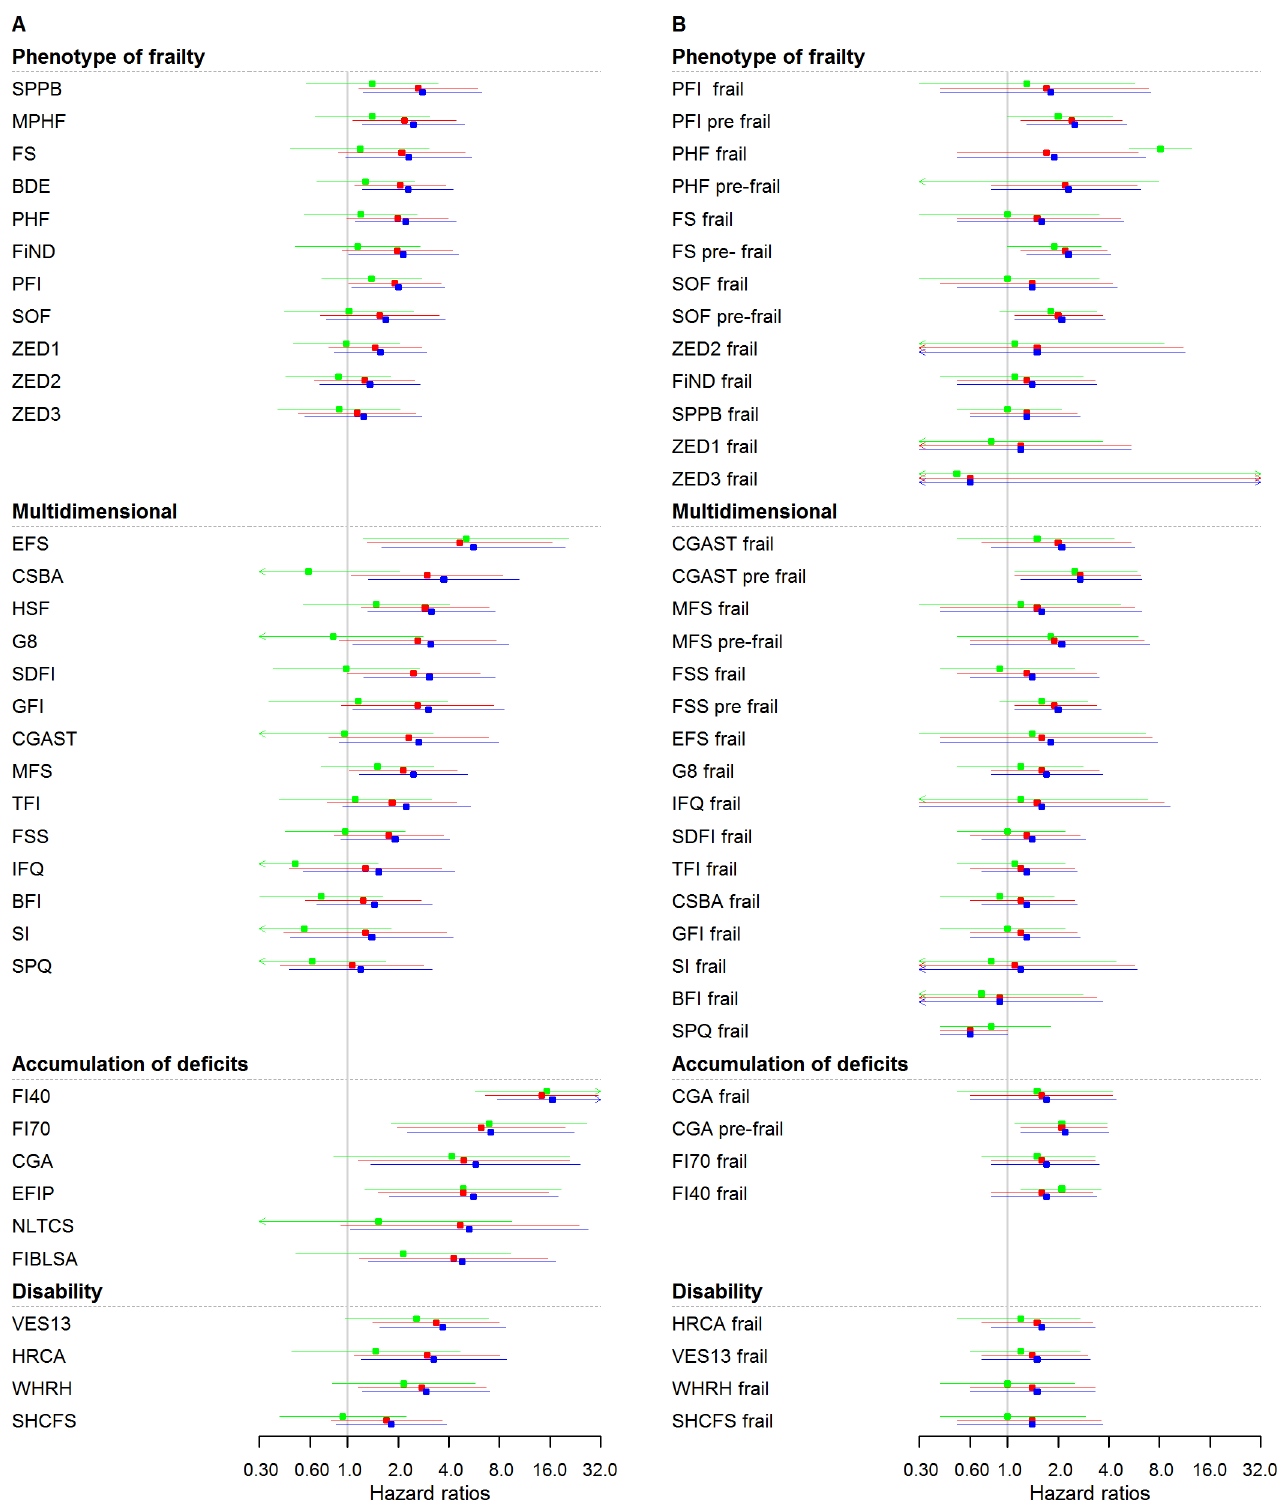
Fig 2. Cardiovascular HRs of frailty scores ( n = 4,554): Continuous and cutoff analysis. (A) Left panel: continuous anaylsis; (B) right panel: categorical analysis. Models were fitted using age as timescale, with time 0 = age at entry of study and time 1 = age at event or censoring date. Model 1 in blue: adjusted by sex. Model 2 in red: Model 1 + smoking status, alcohol, and alcohol consumption. Model 3 in green: Model 2 + physical activity, BMI, diabetes, hypertension,